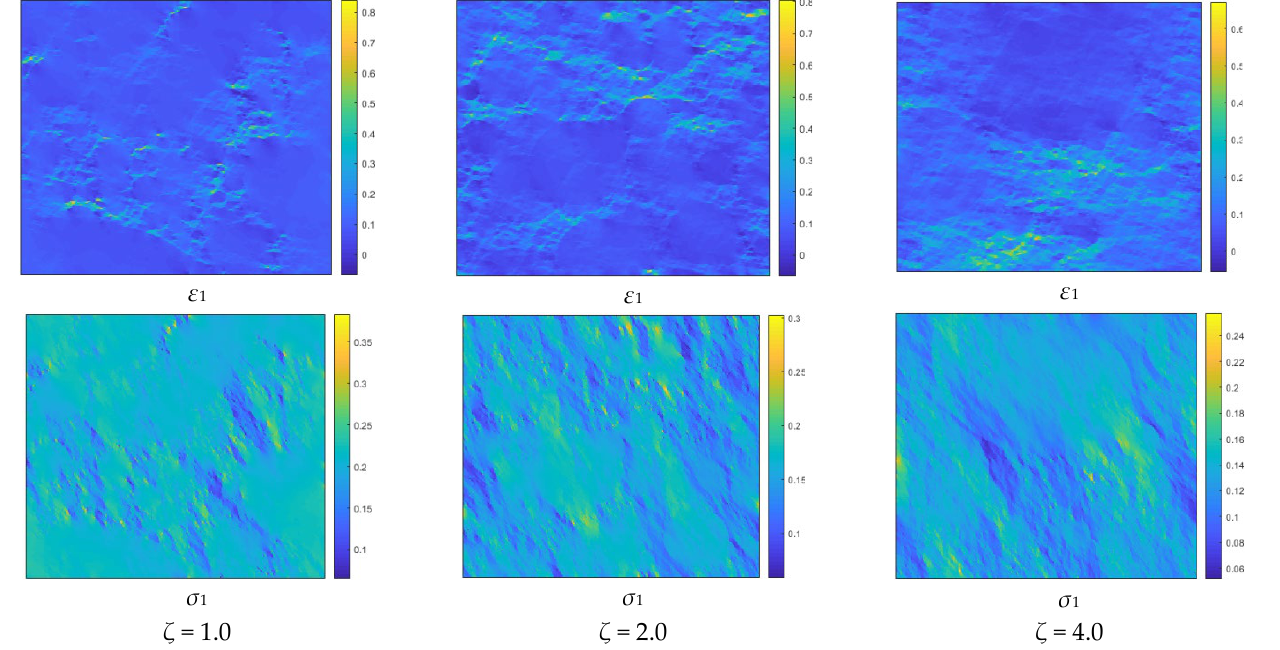
Figure 11. Dimensionless strain and stress (ε 1 , σ 1 ) within multifractal porous materials synthesized by the compound Poisson cascades. Table 2. Macroscopic porosity <f> and effective elastic modulus E eff / E 0 of multifractal porous mate- rials synthesized by the two-parameter binomial multiplicative cascades.